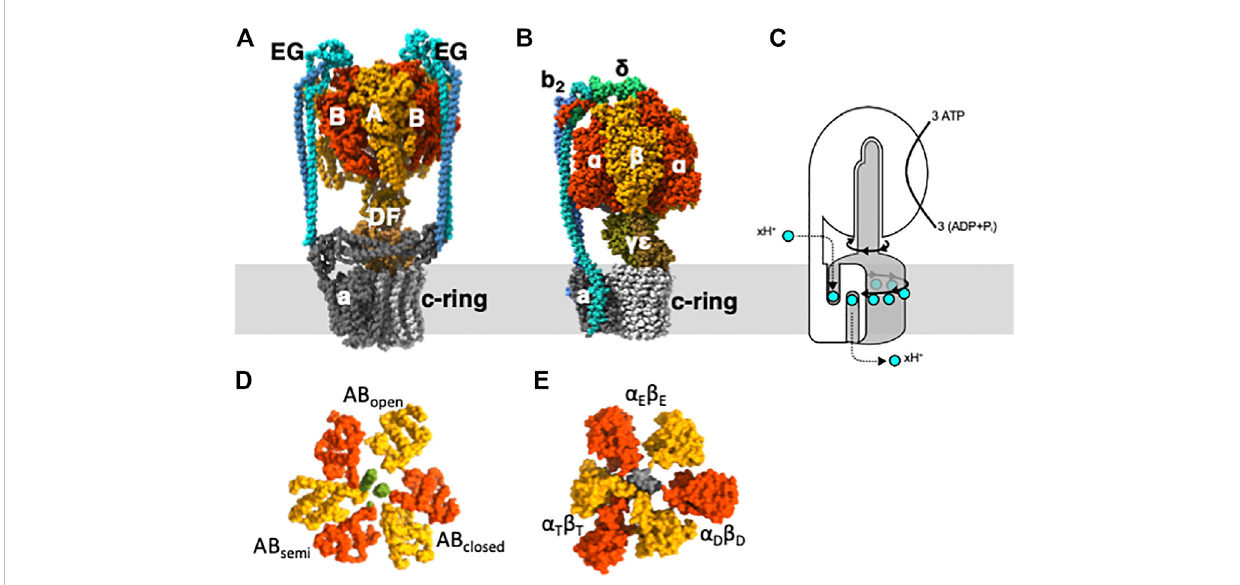
FIGURE 1 Subunit structure and function for V-type and F-type ATPases. (A) V/A-ATPase from Thermus. thermophilus . (B) bacterial F o F 1 ATPase from Geobacillusstearothermophilus . (C) The schematic representation illustratestherotary catalytic mechanismof rotary ATPases, where therotation ofthe central rotor complex (grey) driven by ATP in the surrounding stator apparatus (white) rotates the membrane-embedded c-ring, leading to the translocation of protons across the membrane. Slice view of the C-terminal domain of V 1 (D) and F 1 (E) .